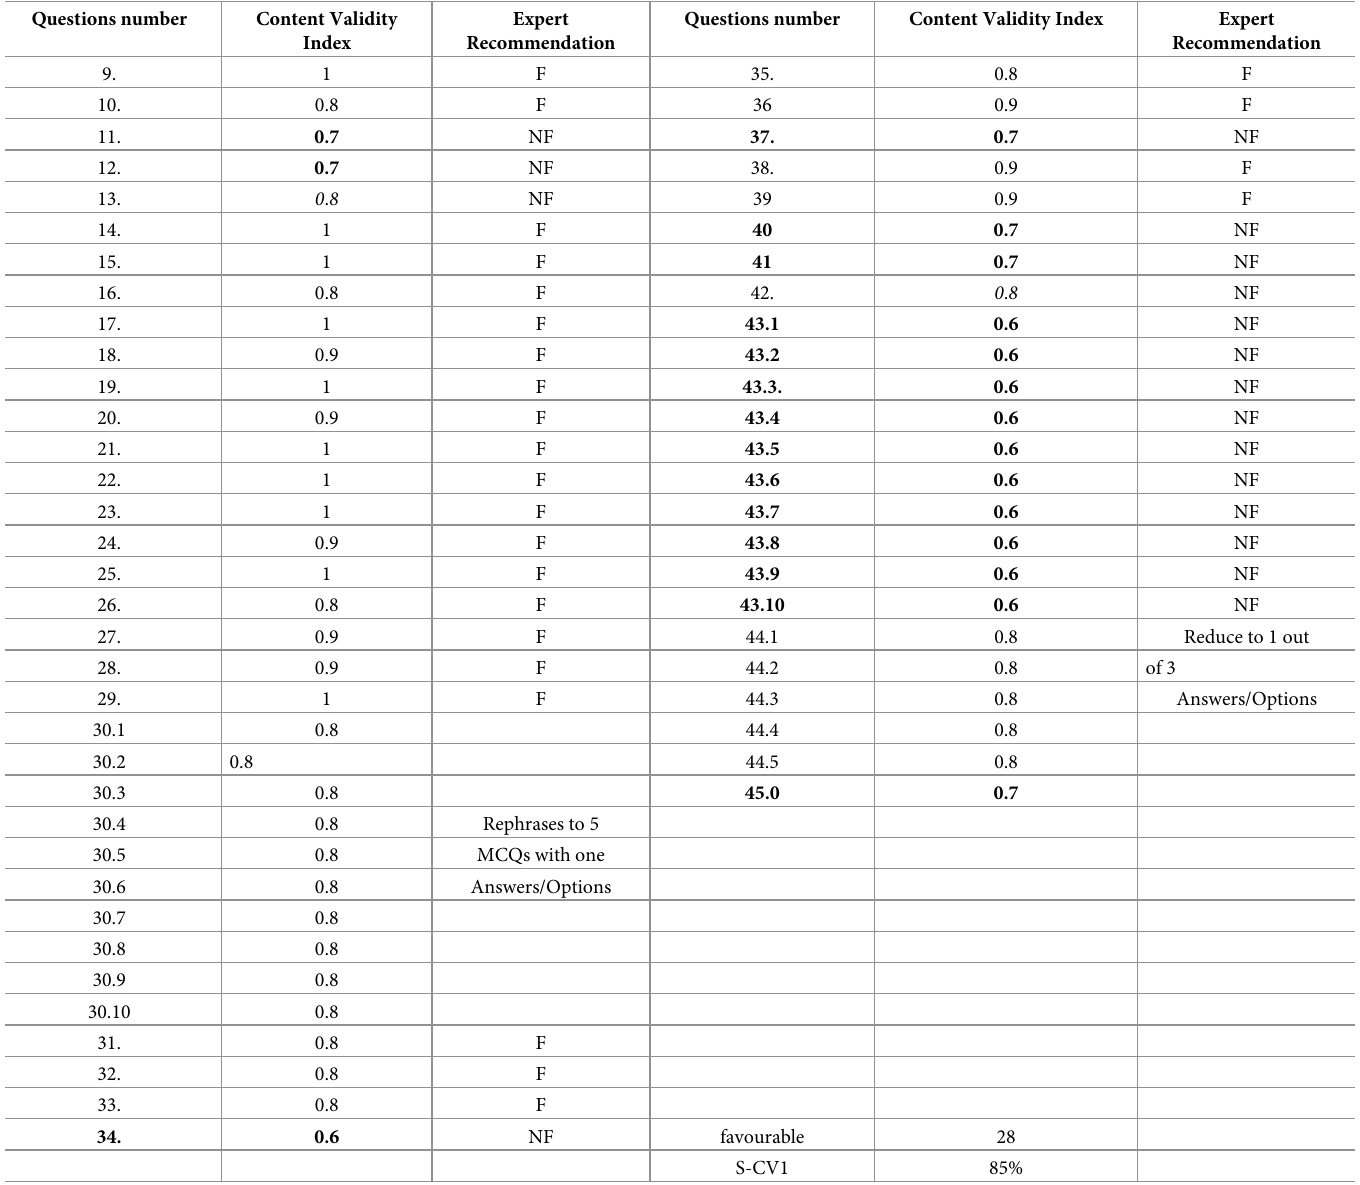
Table 1. Content validity index of questions